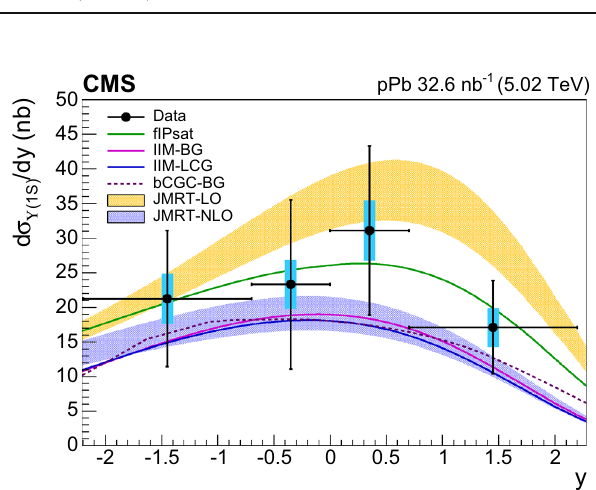
Fig. 5 Differential ϒ( 1S ) photoproduction cross section as a func- √ = 5 . 02TeV in the s tion of rapidity measured in pPb collisions at NN dimuon rapidity region | y | < 2 . 2, compared to various theoretical pre- dictions[10,15–19].Thehorizontalbarsareplottedtoindicatethewidth ofeach y bin. Theverticalbars representthestatisticaluncertaintiesand the boxes represent the systematic uncertainties of the gluon density of the proton, and since the gluon dis- tribution at low Bjorken x is well described by a power law, the cross section also follows a power-law energy